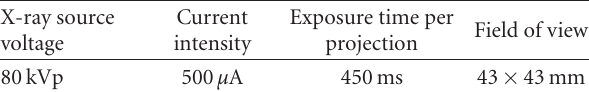
Table 1: Micro-CT data acquisition